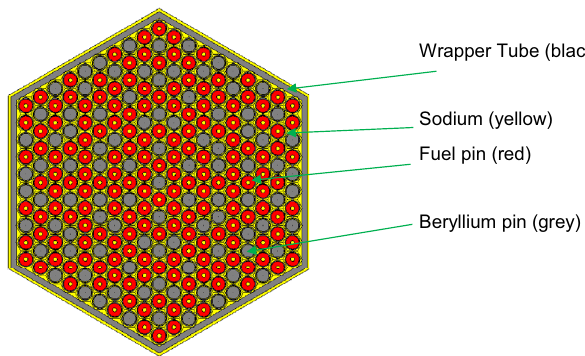
Fig. 4. CADOR fuel assembly (radial cut).